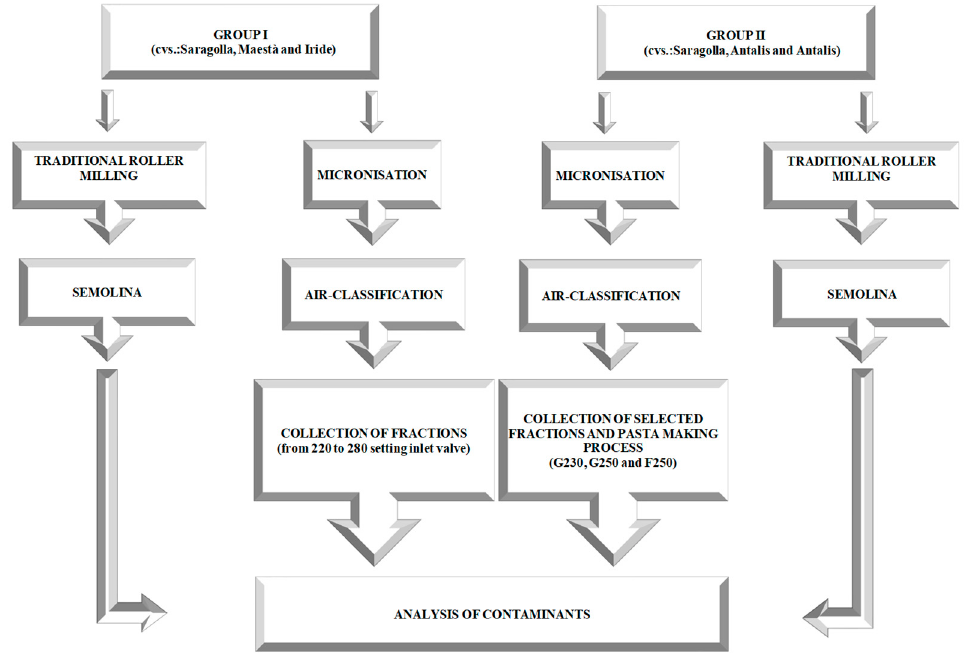
Figure 1. Flow chart of the experimental plan.